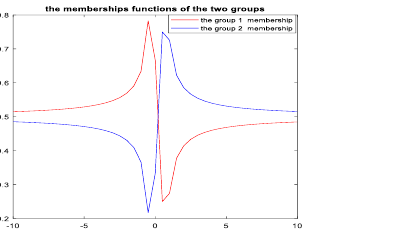
Figure 5. Fuzzy membership functions, conv-fuzzy-probability densities, and probability densities of two clusters.